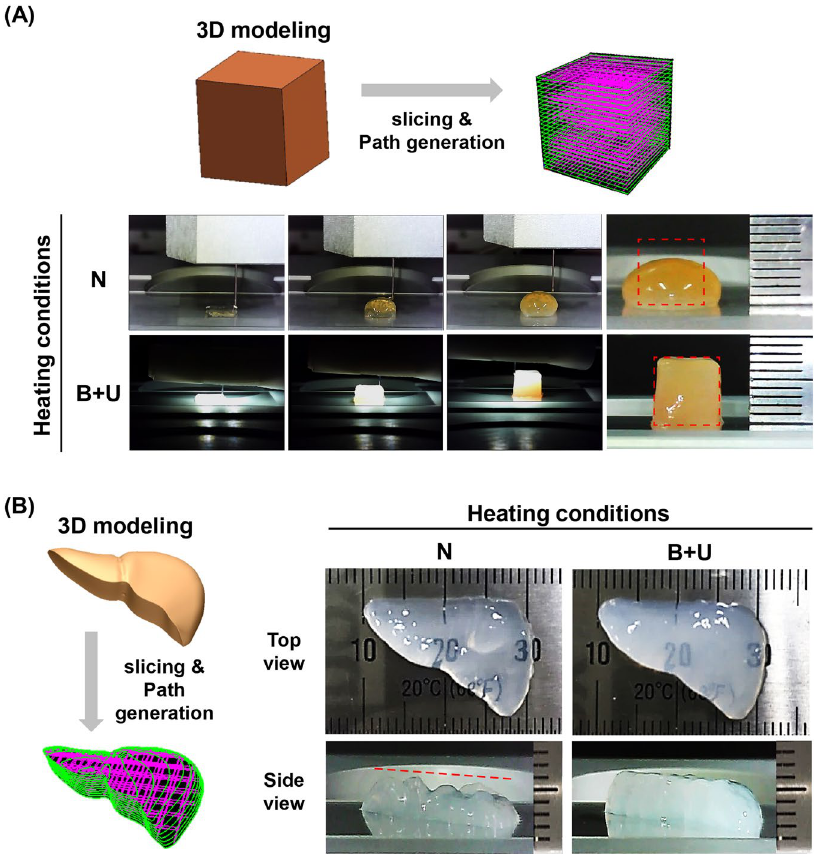
Figure 8. 3D stacking results. ( A ) Observation of stacking efficacy of the heating system using rectangular- shaped constructs. Red-dotted square line indicates the predesignated shape. ( B ) 3D modelling of a liver-shaped construct and generation of printing code and 3D printing results of liver-shaped constructs under non-heating (N) and heating (B + U)